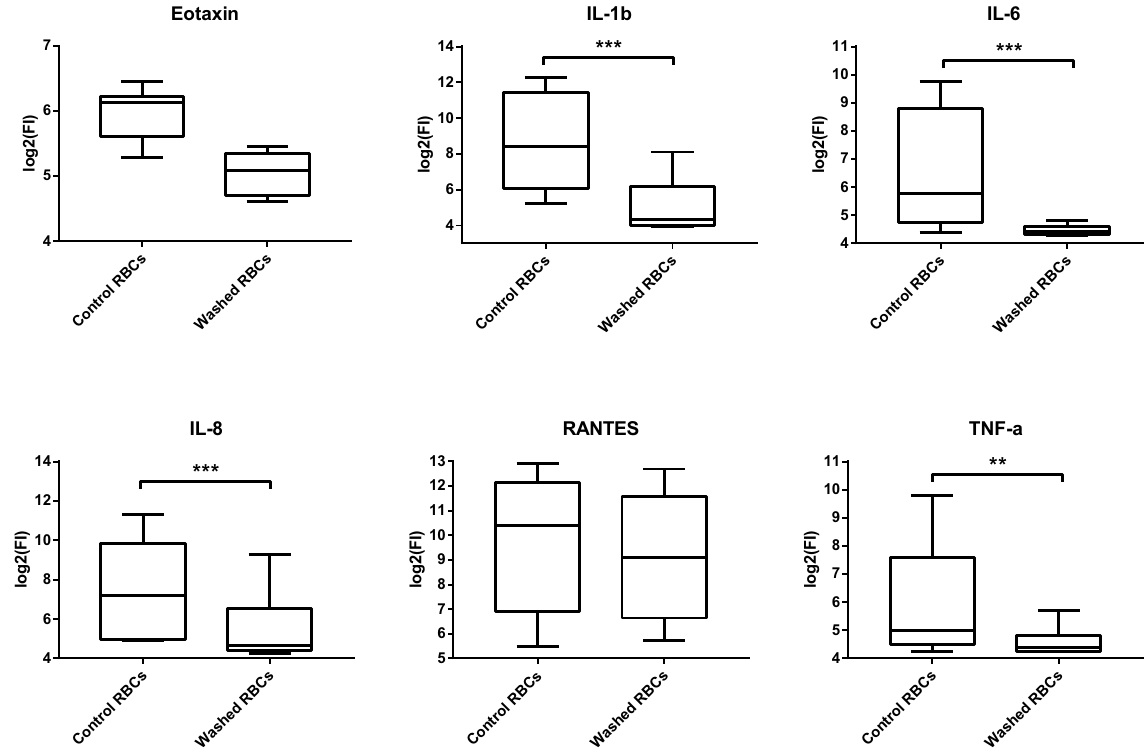
Figure 4. Cytokines in cell lysates and conditioned media following cell washing. Concentration of cytokines in the conditioned media of RBCs washed once (control RBCs) or ten times (washed RBCs) and subsequently incubated in PBS (400 × 10 6 cells per mL) for 24 hours at 37 °C as measured by Bio-Plex. Data are presented as mean with minimum and maximum values ( n = 10). Data are significant if p < 0.05 ( * ), p < 0.01 ( ** ), or p < 0.001 ( ***